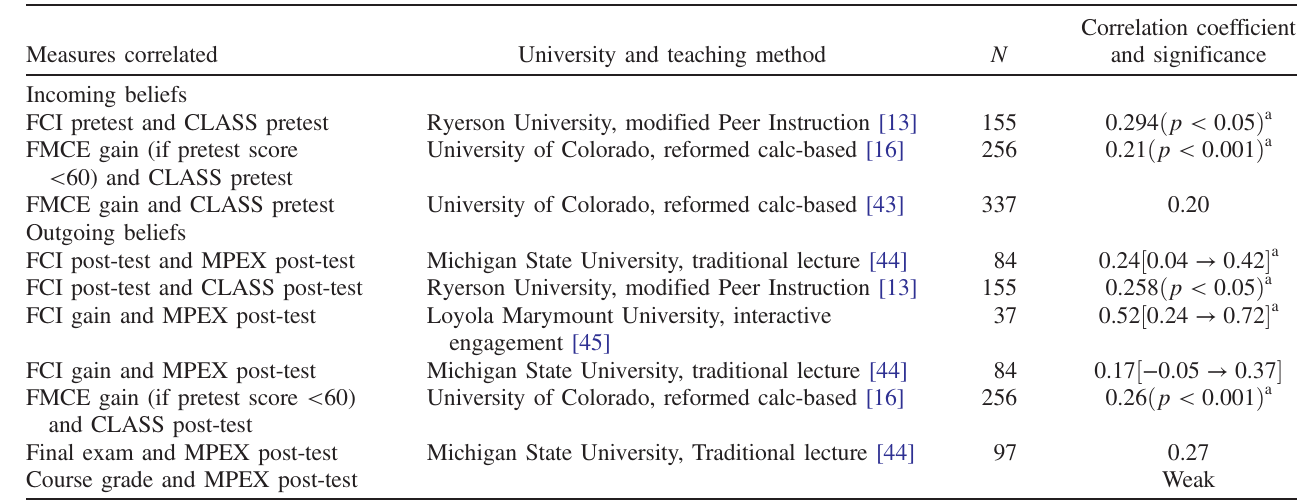
TABLE X. Correlations between surveys of beliefs about learning physics and other measures of learning. Numbers in brackets indicate the confidence interval which is significant if zero is not in the interval. Measures